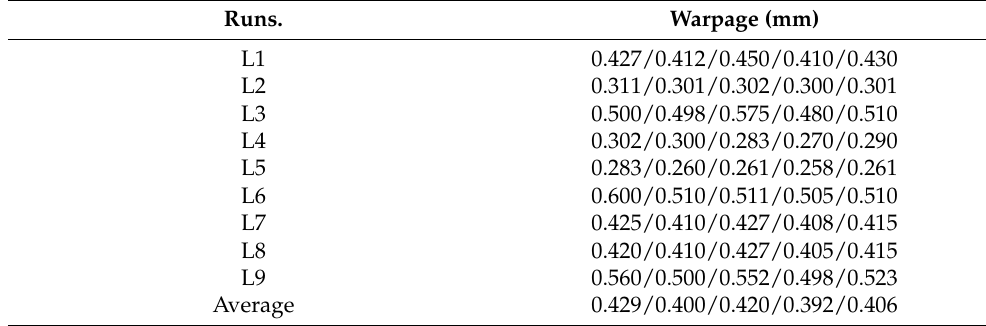
Numerical simulation of the warpage of micro-sized parts for PIM (POM/ABS/PP/PA/ABS + PC).